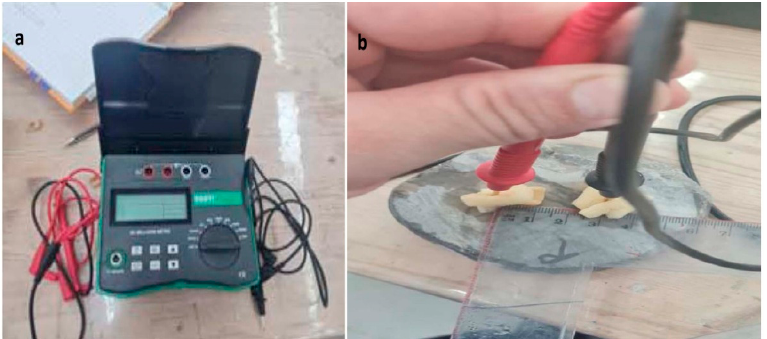
Figure 12. ( a ) The tool for electric resistivity measurements; ( b ) the measurement of electric resistivity of chert sample.